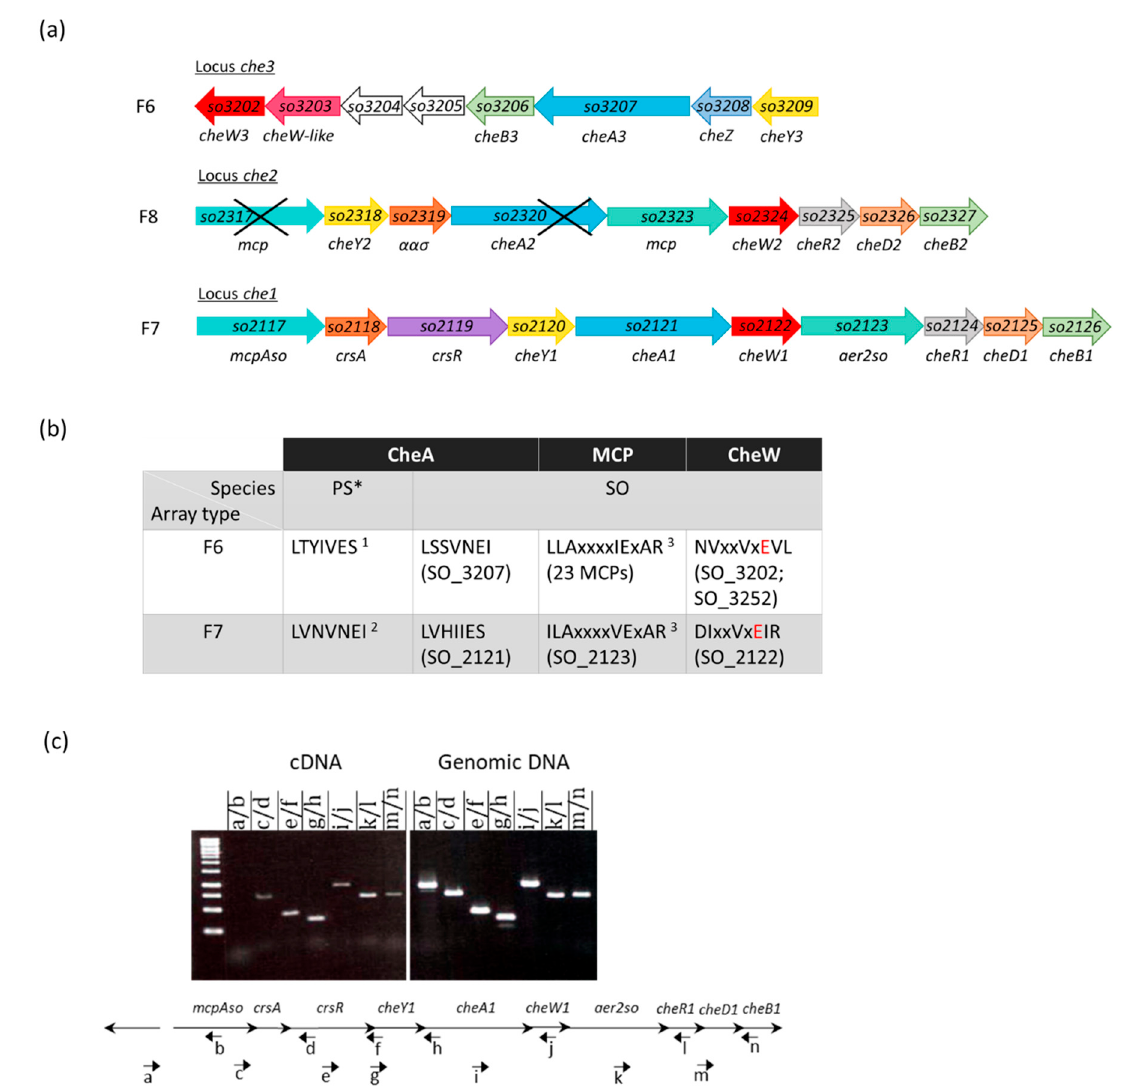
Figure 1. Chemosensory systems in S. oneidensis . ( a ) Gene clusters of S. oneidensis MR1 encoding the three chemosensory systems. Black crosses in che2 locus indicate the presence specific to this strain of insertion sequences; ( b ) consensus motifs found in CheA, CheW, and MCPs in S. oneidensis (SO). Motifs were defined based on motifs defined in Pseudomonas species [17] (PS *): 1 from the motif “LTYIVES” established in F6 CheA sequences, 2 from the motif “LVNVNEI” established in F7 CheA sequences, and 3 same motif as defined in Pseudomonas species . Red cases, highly conserved glutamate in CheW sequences; ( c ) analysis of che1 transcription by RT-PCR. Black small arrows and lowercase stand for the direction and name of primers. The PCR experiments were carried out using either cDNA or genomic DNA as a template and with different couples of primers, as indicated below the gel. The cDNA was obtained by the reverse transcription of RNA extracted from S. oneidensis cells grown in aerobiosis and sampled during the exponential phase. The amplification products